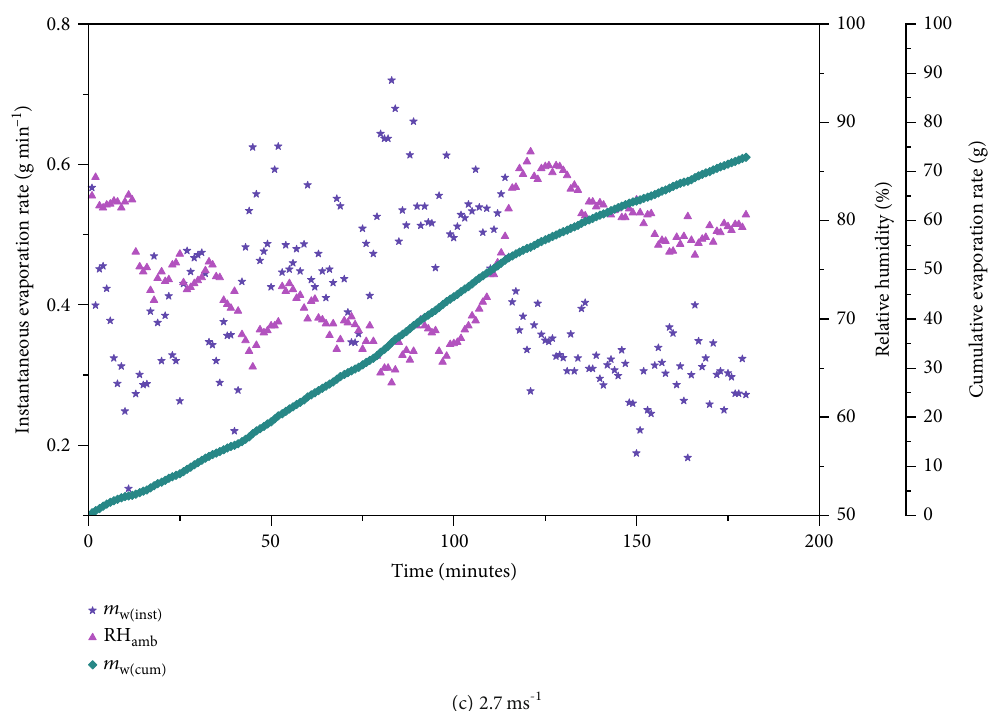
Figure 15: Ambient RH and instantaneous and cumulative evaporation rates of the air cooler at three di ff erent velocities under high RH